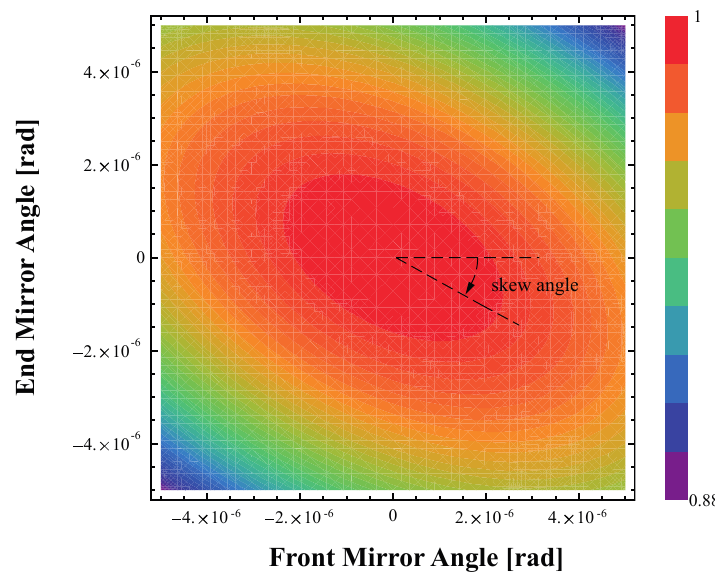
Figure 4. Transmitted beam intensity